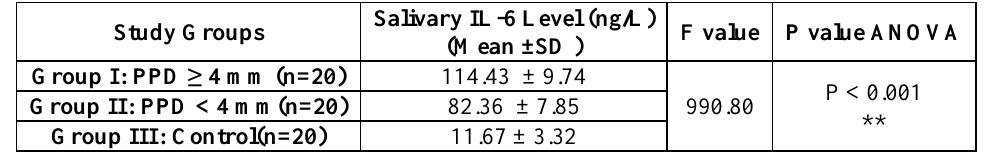
Table 2: ANOVA Test for Detection ofSalivary IL-6 (ng/L) Level in Different Study Groups.